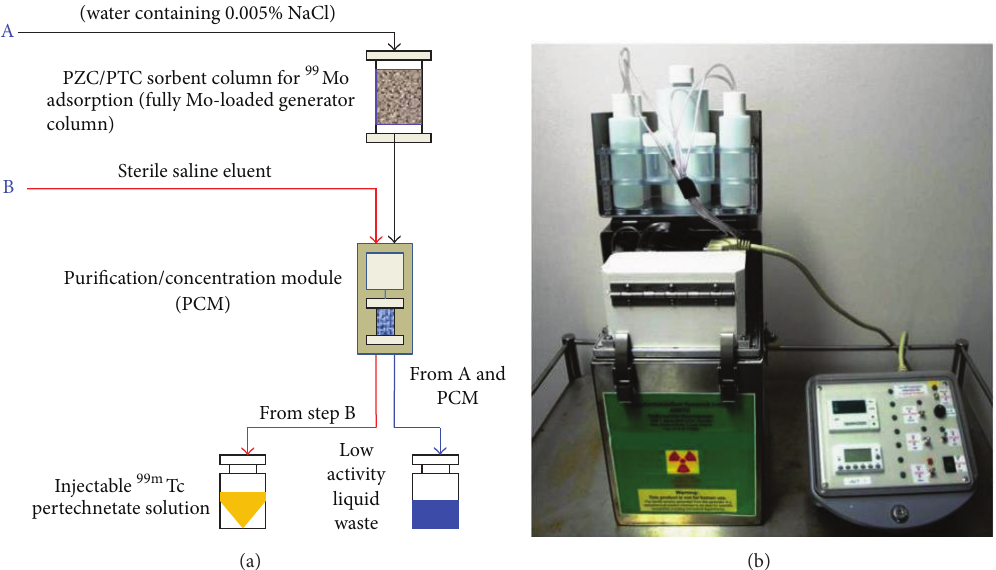
Figure 16: Integrated radioisotope generator system (radionuclide generator column coupled with an automated purification/concentration unit of the programmable time sequence control): (a) process diagram; (b) photo of the system recently developed at MEDISOTEC